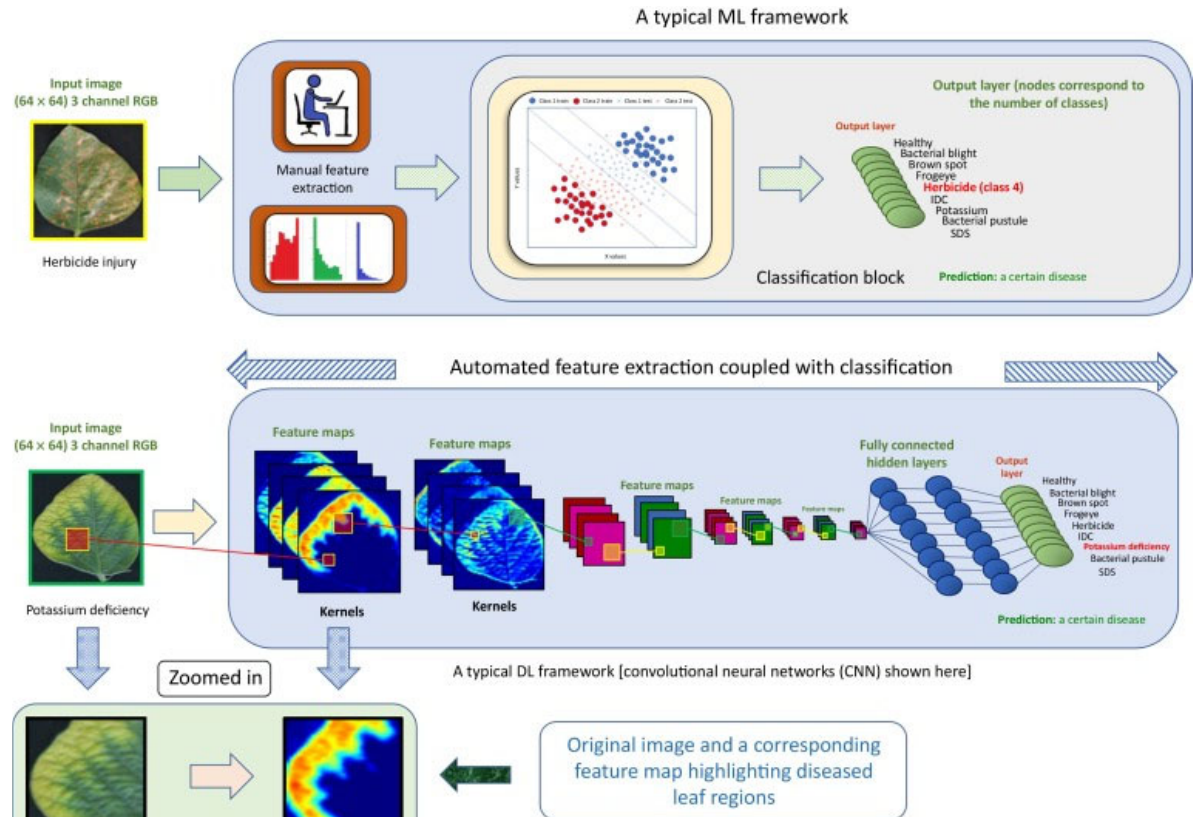
Figure 7. Identi fi cation of plant leaf diseases using CNN [77]. Figure 7. Identification of plant leaf diseases using CNN